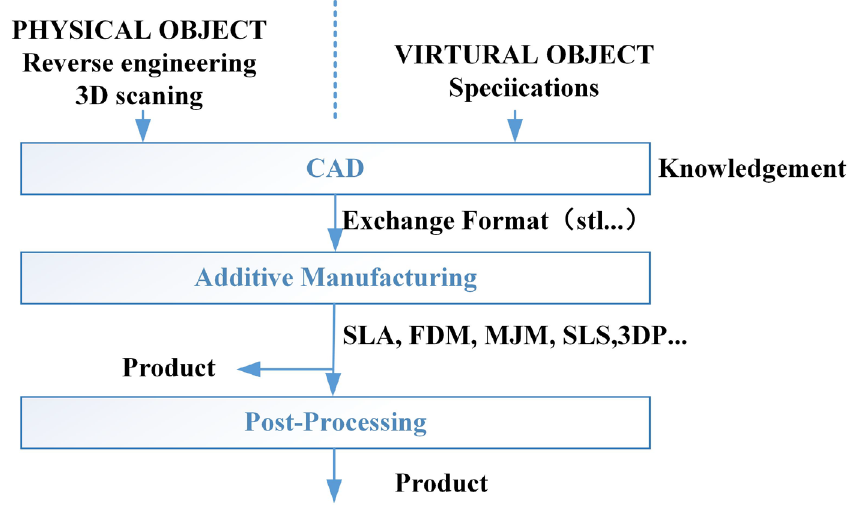
Figure 6. Three-dimensional printing process [91]. Table 5. Established rapid prototyping technologies.